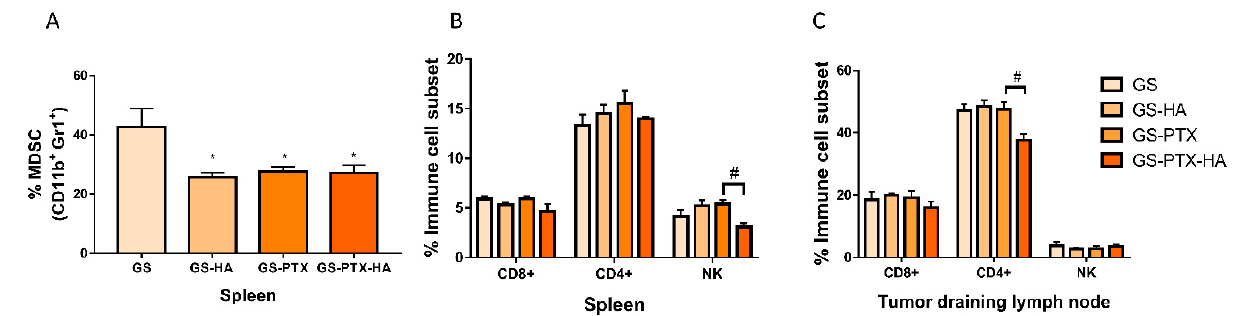
Figure 8. Immune cell subsets distribution. Cell suspensions from spleen and tumor draining lymph nodes-bearing mice were labelled with specific antibodies: ( A ) CD11b-PE and GR1-FITC: Myeloid-derived suppressor cells (MDSC), ( B , C ) CD4-FITC: T helper lymphocytes marker; CD8-PE: T cytotoxic lymphocytes marker and CD49-PE and CD3-FITC: Natural killer (NK) markers. Error bars represent the mean ± SD (ANOVA and Tukey’s multiple comparisons test, * p < 0.05 vs. GS, # p < 0.05 vs. GS-PTX).